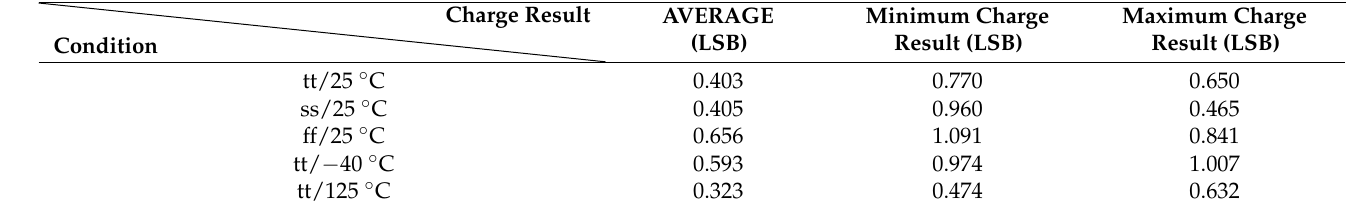
Figure 5. Distribution comparison of INLs as percentages. Table 1. Average INL of maximum, minimum, and average charge results achievable when using different combinations under different conditions.